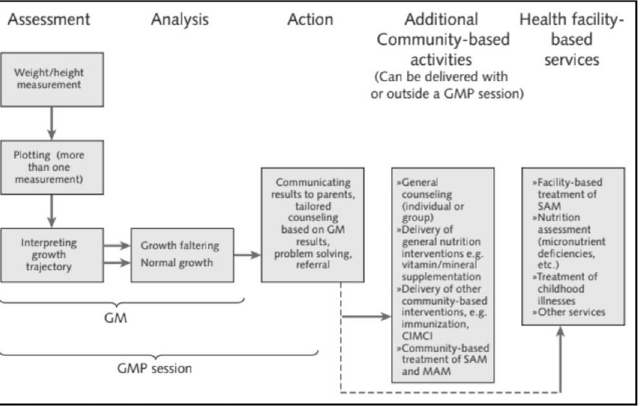
Fig 1. GMP process. Adapted from: Mangasaryan, Arabi, and Schultink, 2011, P. 47, CIMCI: community-based integrated management of childhood illness | SAM: severe acute malnutrition | MAM: moderate acute